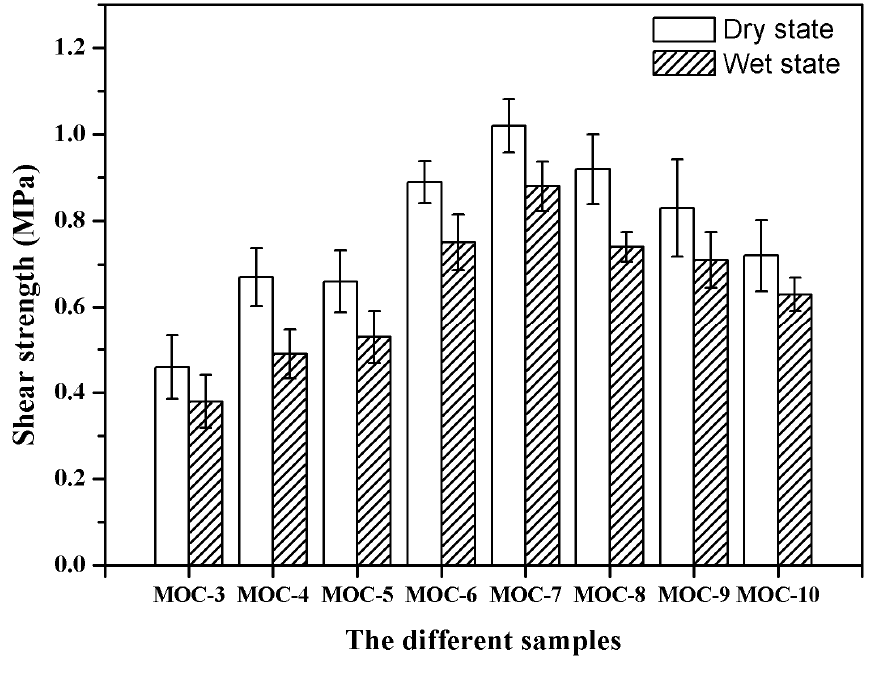
Figure 6. The shear strength of plywood bonded by the MOC adhesives. Table 4. Dry and wet shear strength data of the plywood samples.